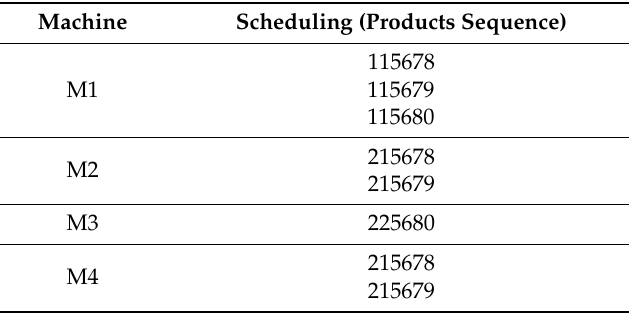
Table 4. Machines scheduling in the undisturbed